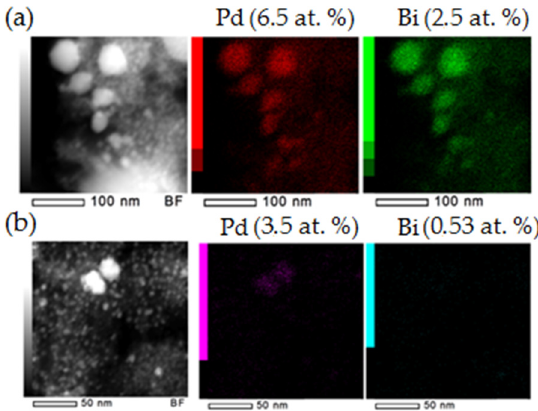
Figure 4 . Elemental mapping of the surface of the Pd → Bi/Al 2 O 3 catalyst by EDS at ( a ) 600,000× magnification and ( b ) 1,000,000× magnification.